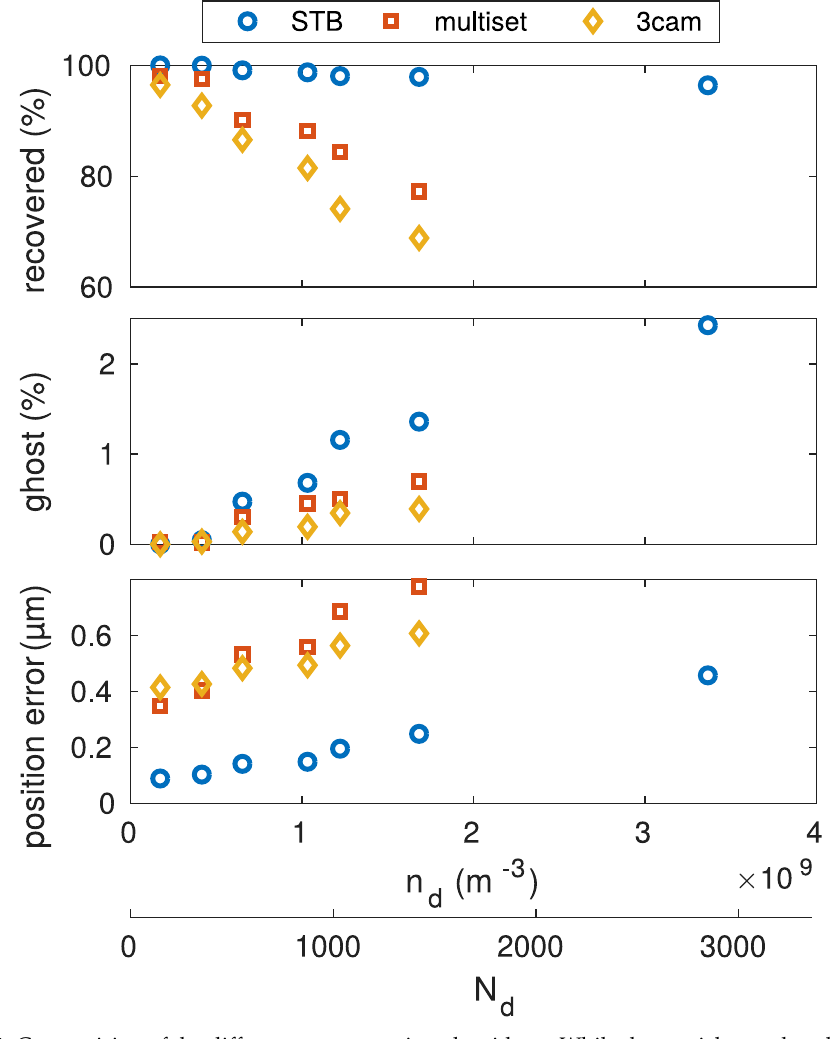
Figure 4. Comparision of the different reconstruction algorithms. While the particle number density n d was varied, the positioning accuracy, the percentage of the reconstructed particles, and the percentage of reconstructed ghost particles were determined. The crystalline dataset with a wide-angled camera setup has been used as basis